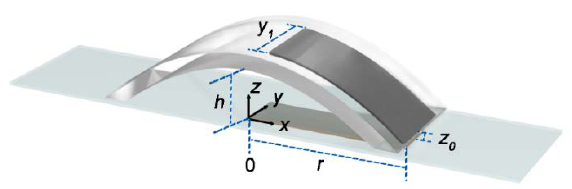
Figure 6. A schematic of the semi-ellipse in the X-shaped actuator with parameters and coordinate definitions.